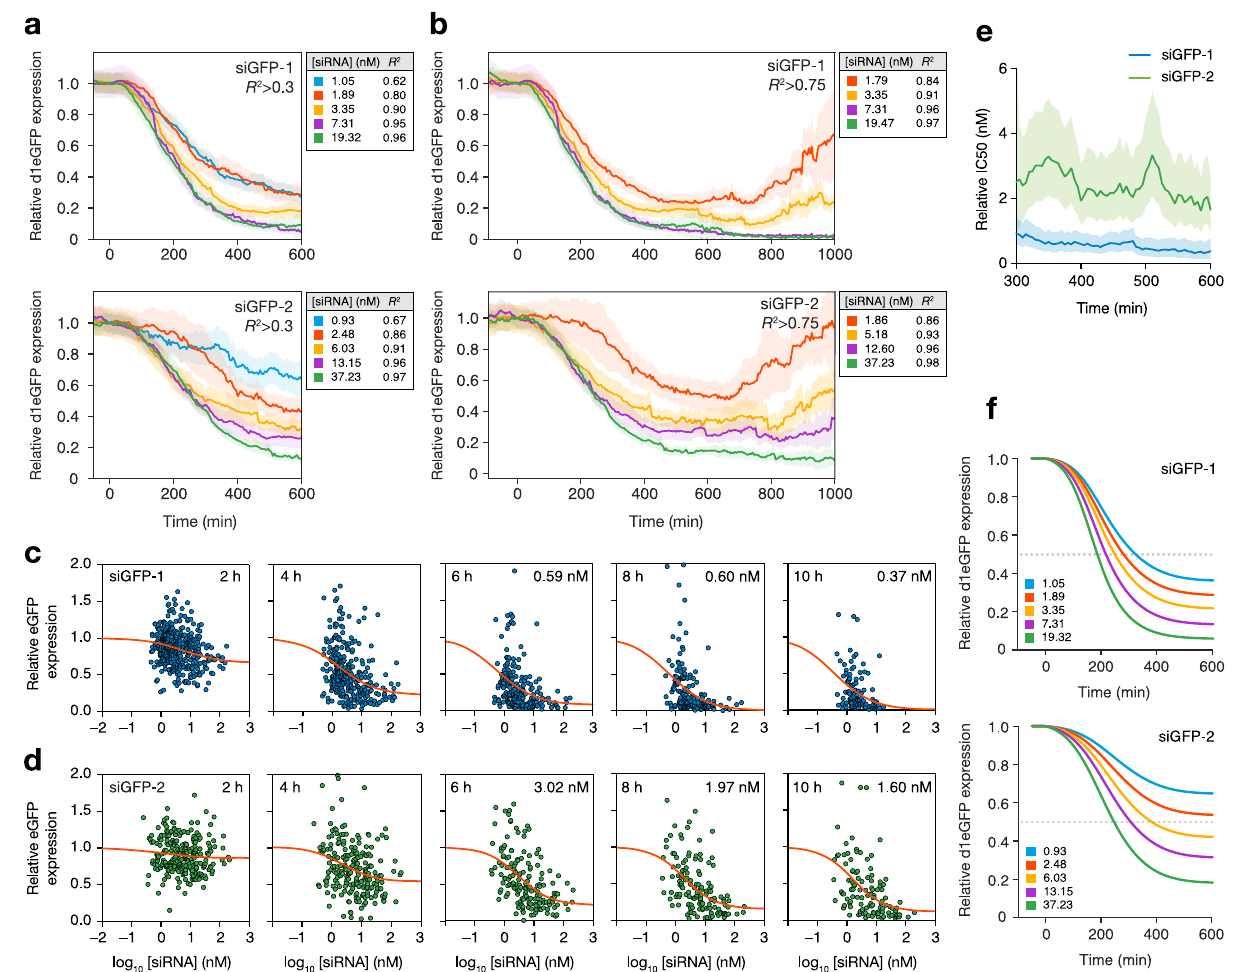
Fig. 5 | Single-cell knockdown kinetics are dose-dependent with respect to cytosolic siRNA amounts. HeLa cellsstably expressing d1-eGFP were treated with 40 – 2000pMlipoplexed AF647-siRNA targetingeGFP.A confocalmicroscope with anAiryscandetectorwasusedforlive-cellimaging,followedbysingle-cellanalysis. a , b Cells were ordered and divided into equal groups based on the model- estimated magnitude of siRNA release events. Traces are aligned with t =0 at the time of cytosolic siRNA detection. Lines are mean eGFP expression per quantile, shaded areas are 80% con fi dence intervals. Median cytosolic siRNA concentration (nM)andmean R 2 -valueperquantileareindicated.Model- fi t( R 2 )thresholdsof>0.3 ( a ) and >0.75 ( b ) were used. N ≥ 92, 58 ( R 2 >0.3) 90, and 59 ( R 2 >0.75) cells per quantile for siGFP-1 and siGFP-2, respectively. c , d Single-cell knockdown kinetics between 2 and 10h after siRNA release. Model-estimated peak cytosolic siRNA